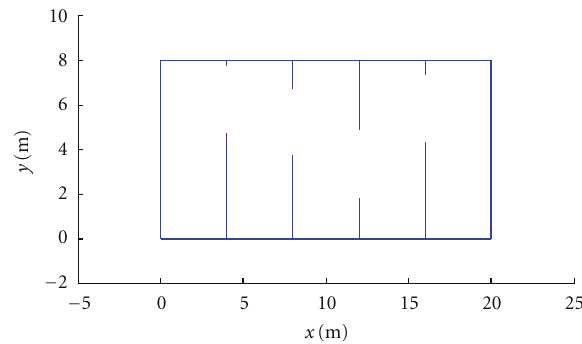
Figure 13: Example of a test environment used for assessing the computational e ffi ciency of our beam tracing algorithm. The 8m × 4m rooms are all connected together through randomly-located